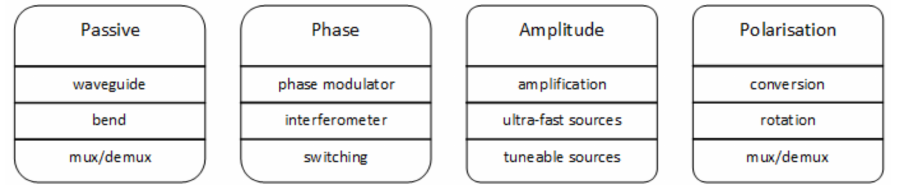
Figure 3. Functionalities that can be realized with the four basic categories of building blocks.